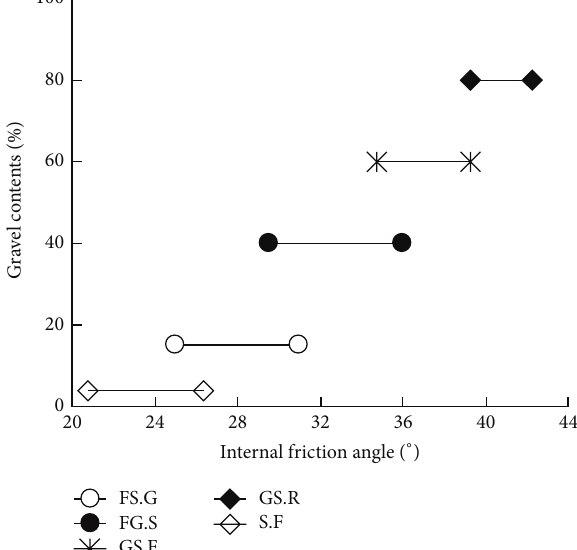
Figure 10: Range of internal friction angle at different granular